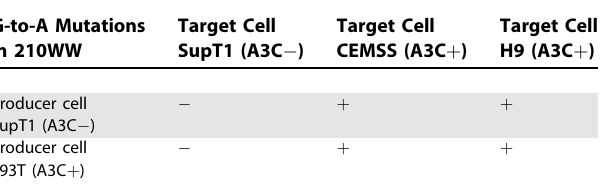
Table 1. Detection of G-to-A Mutations in 210WW Virus Produced in either A3C-Positive or AC3-Negative Cells following Infection of AC3-Positive and AC3-Negative Cells G-to-A Mutations in